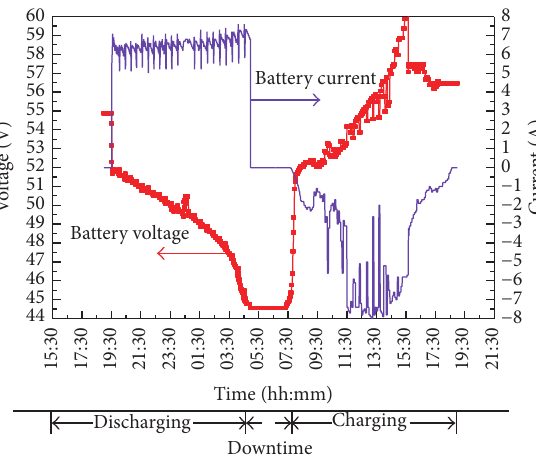
Figure 8: Variations of wind speed and PV modules temperature on 22nd Nov., 2015, in Kunming.